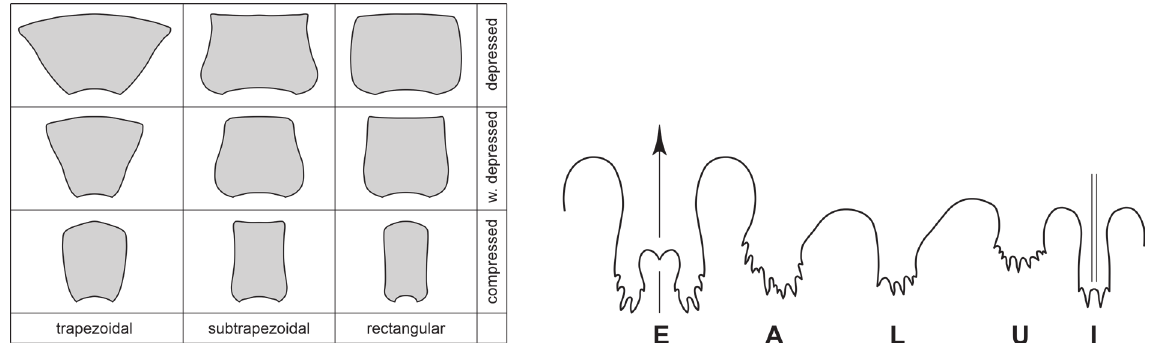
Fig. 15. Descriptive terms for the whorl profiles and suture lines (exemplified in Paratirolites kittli Stoyanow, 1910) of the paratirolitid ammonoids described here (from Korn et al .